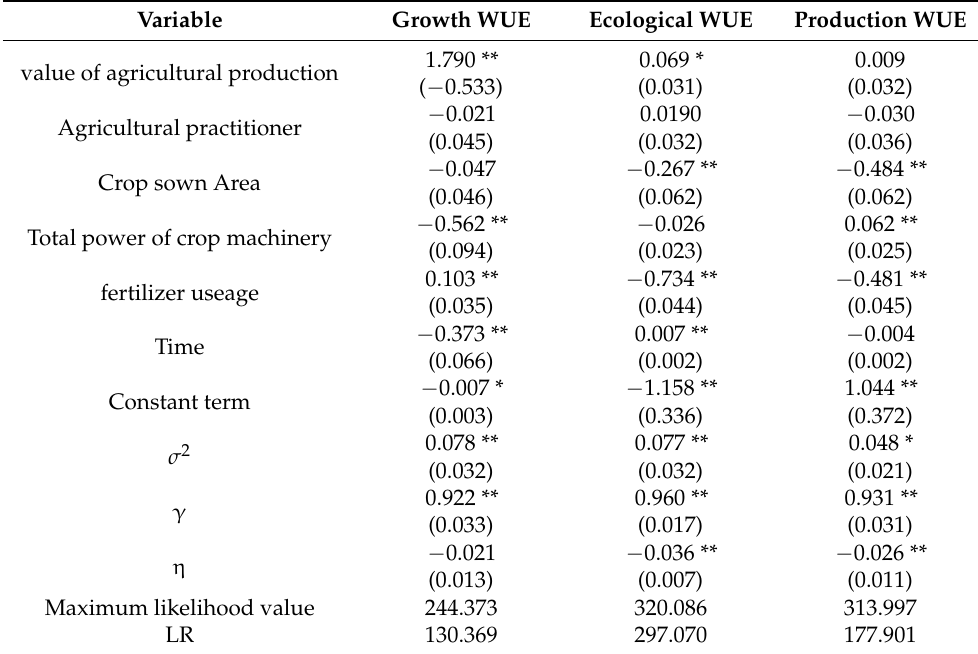
Table 2. The regression results of crop water use efficiency in Liaoning